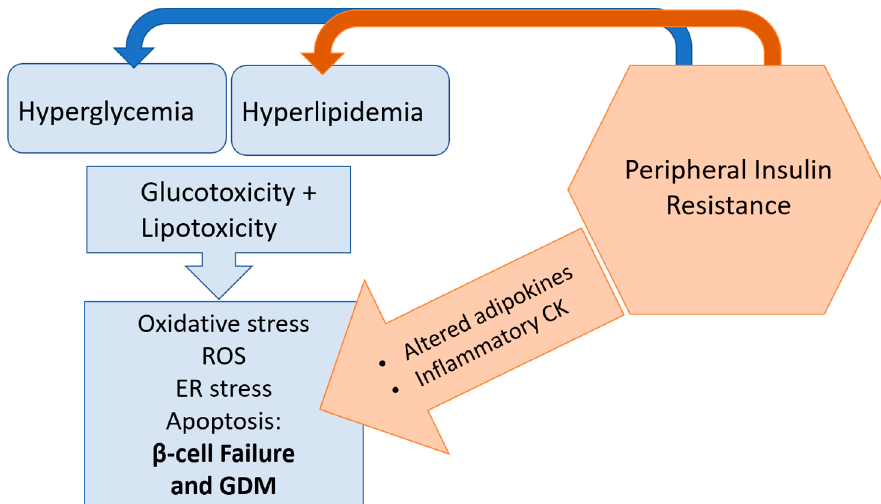
Figure 3. Peripheral insulin resistance and resulting hyperlipidemia and hyperglycemia can overwhelm the capacity of the β -cell, leading to lipotoxicity and glucotoxicity. Lipotoxicity and glucotoxicity can trigger oxidative stress, generation of reactive oxygen species (ROS) and lead to endoplasmic reticulum (ER) stress and apoptosis; these detrimental pathways impair β -cell adaptation in pregnancy and can lead to gestational diabetes mellitus (GDM).